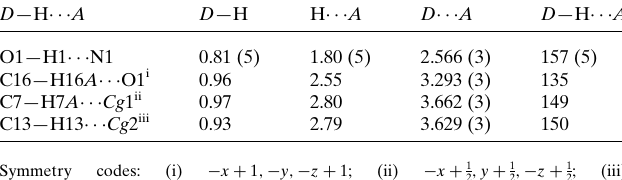
Table 1 Hydrogen-bond geometry (A˚ , (cid:3) ).